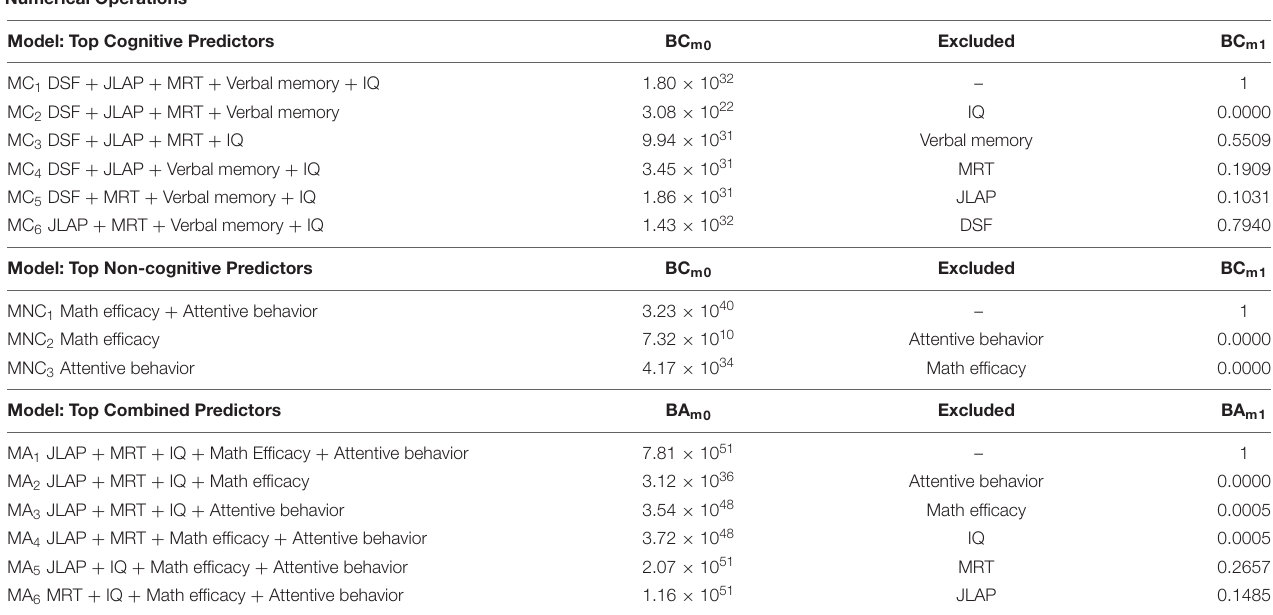
TABLE 4 | Bayes factor analyses of predictors of mathematics achievement.